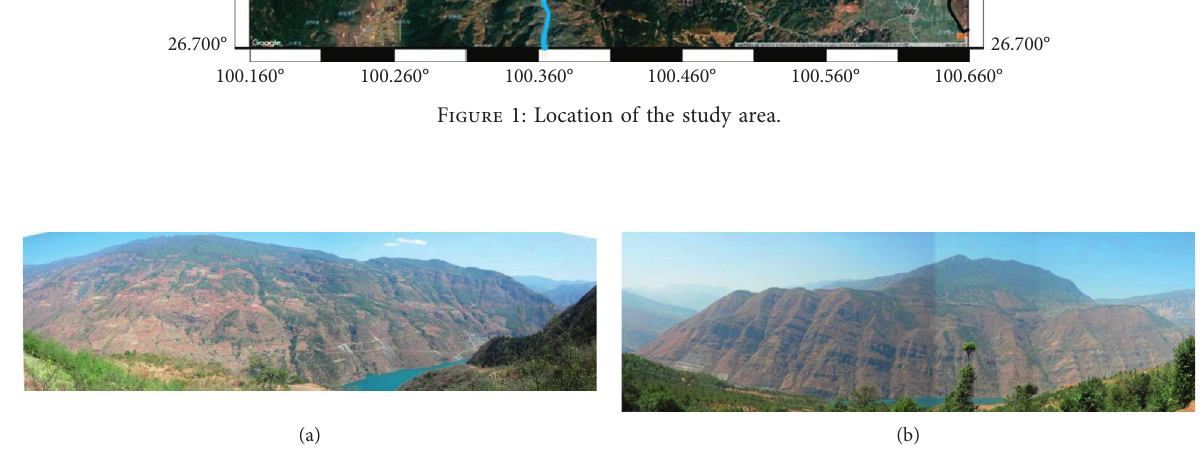
Figure 2: Topography and geomorphology of the slopes: (a) Huaping slope; (b) Lijiang slope.